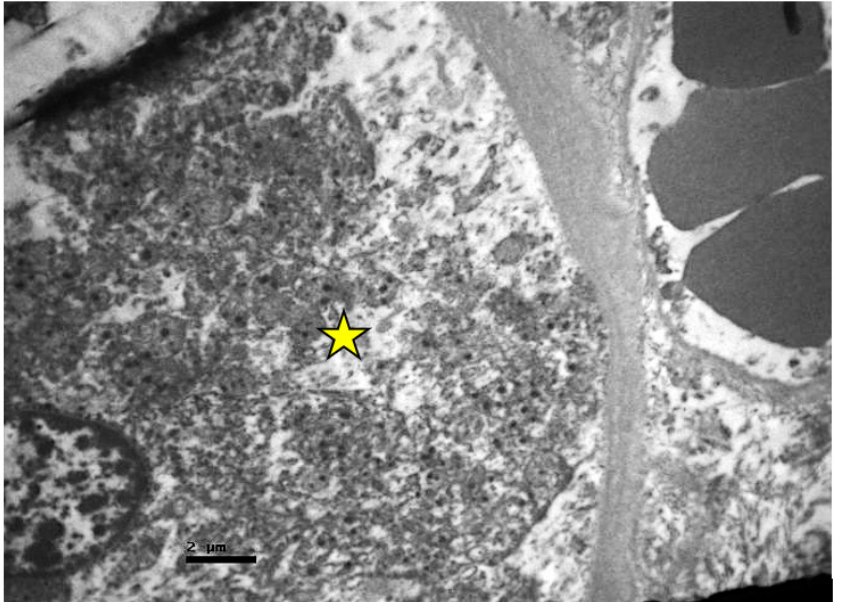
Figure 14. An apoptotic cell of the tubular epithelium of non-resuscitated swine sample (yellow star). The intervening connective tissue revealed the presence of edema, activated fibroblasts, fibrosis, macrophages, apoptotic material, and damaged vascular capillaries, some of which were full of erythrocytes (Figures 15 and 16).